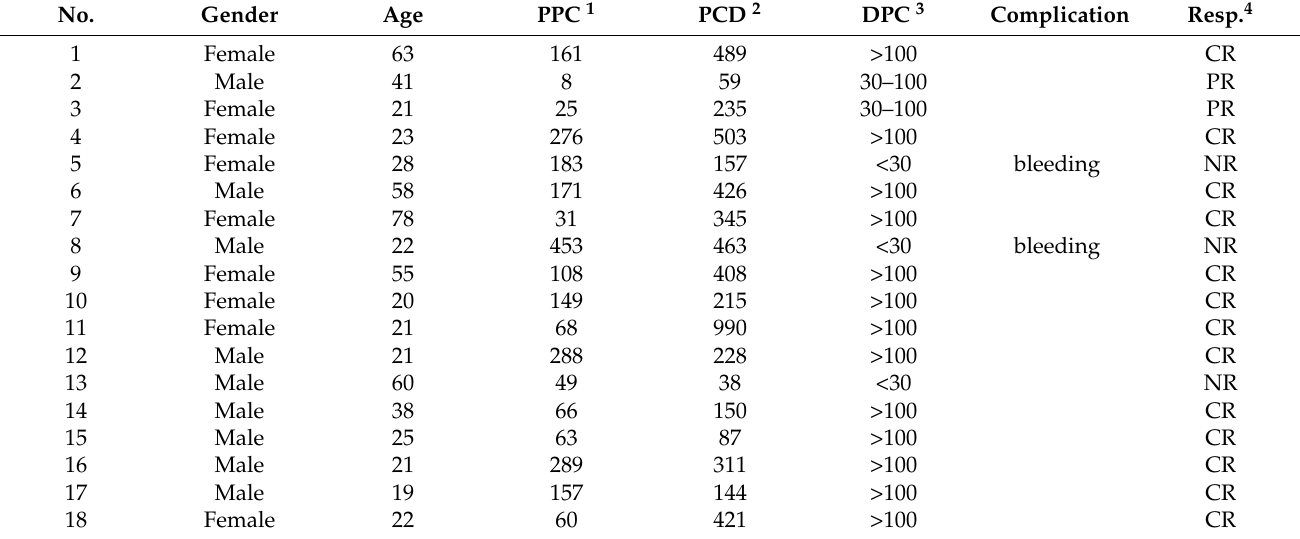
Table 1. Clinical data of ITP